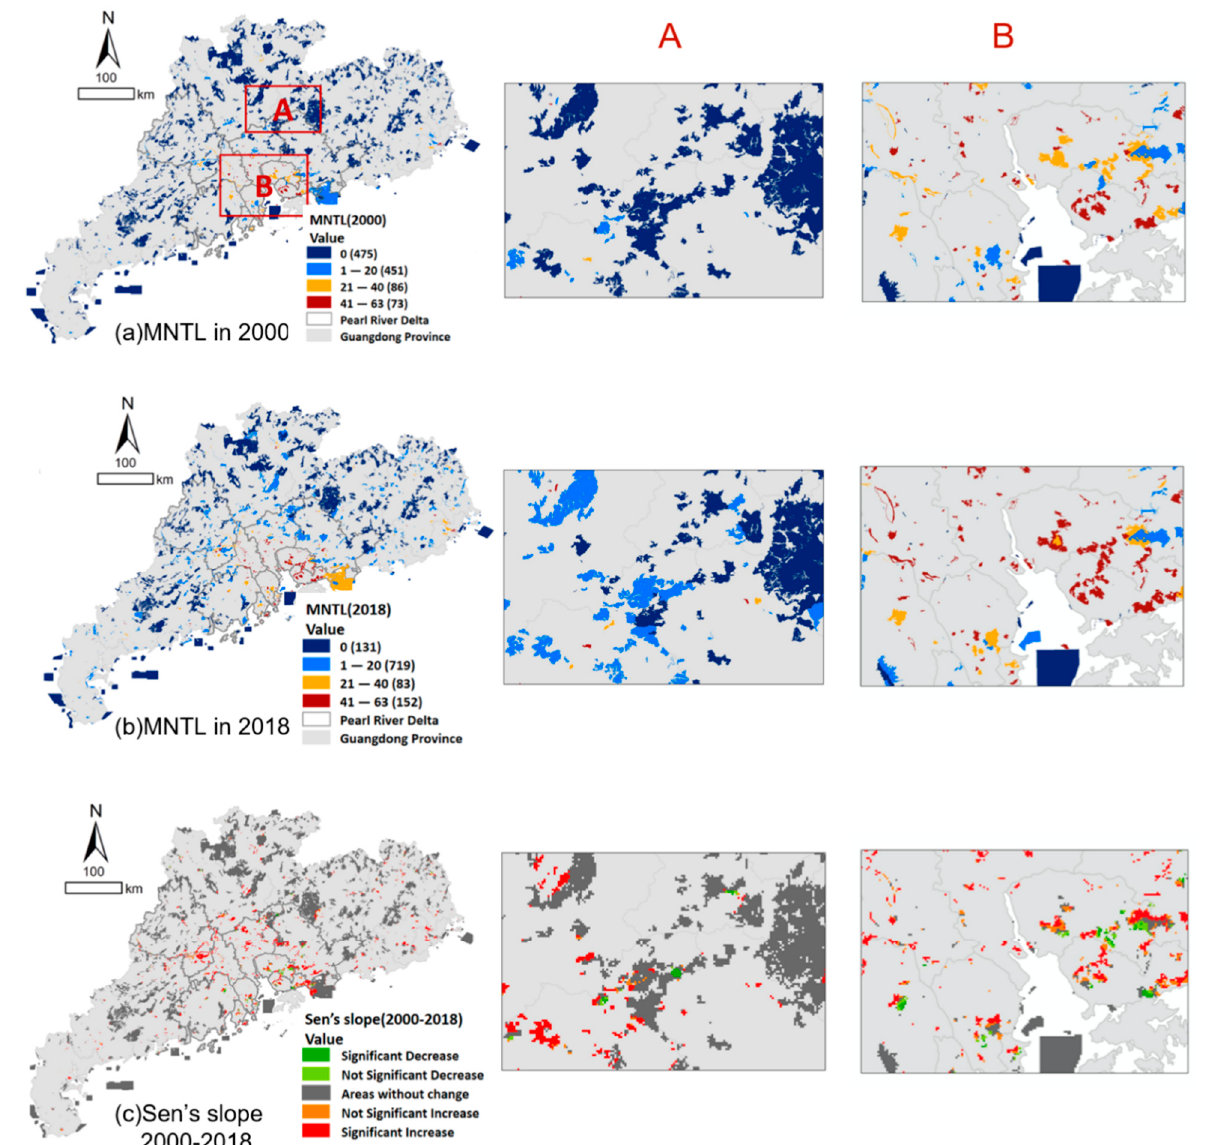
Figure 4. Spatial distribution and dynamics of MNTL.